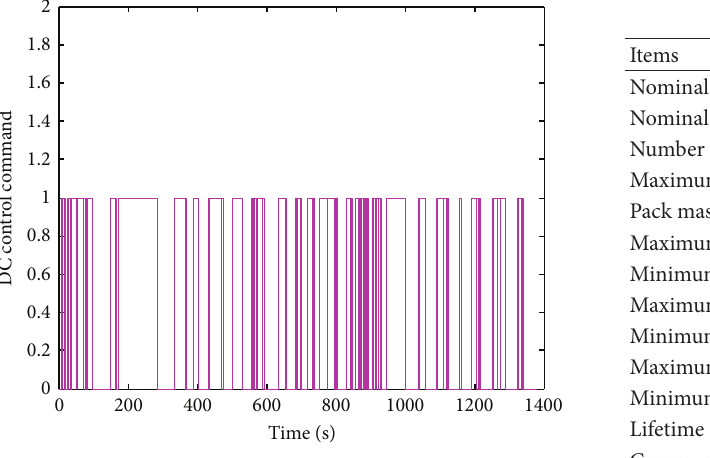
Figure 19: DC/DC converter control command.